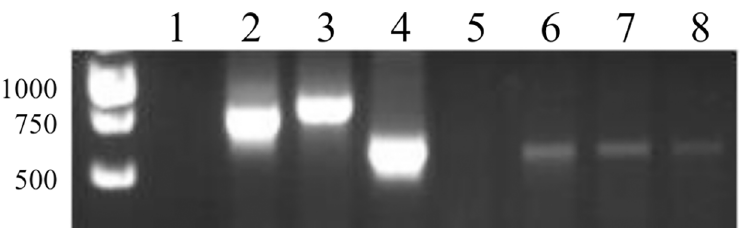
Fig 2. Results of the nested PCR assay used for the identification of Leishmania parasites in rodent samples and reference strains. Lane 1, negative control; lane 2, L . infantum (MHOM/BL/67/ITMAP263); lane 3, L . tropica (MHOM/SU/74/K27); lane 4, L . major (MHOM/SU/1973/5ASKH); lane 5, sample 3119 (negative); lanes 6 to 8, samples 3394, 3441 and 3493 (positive).